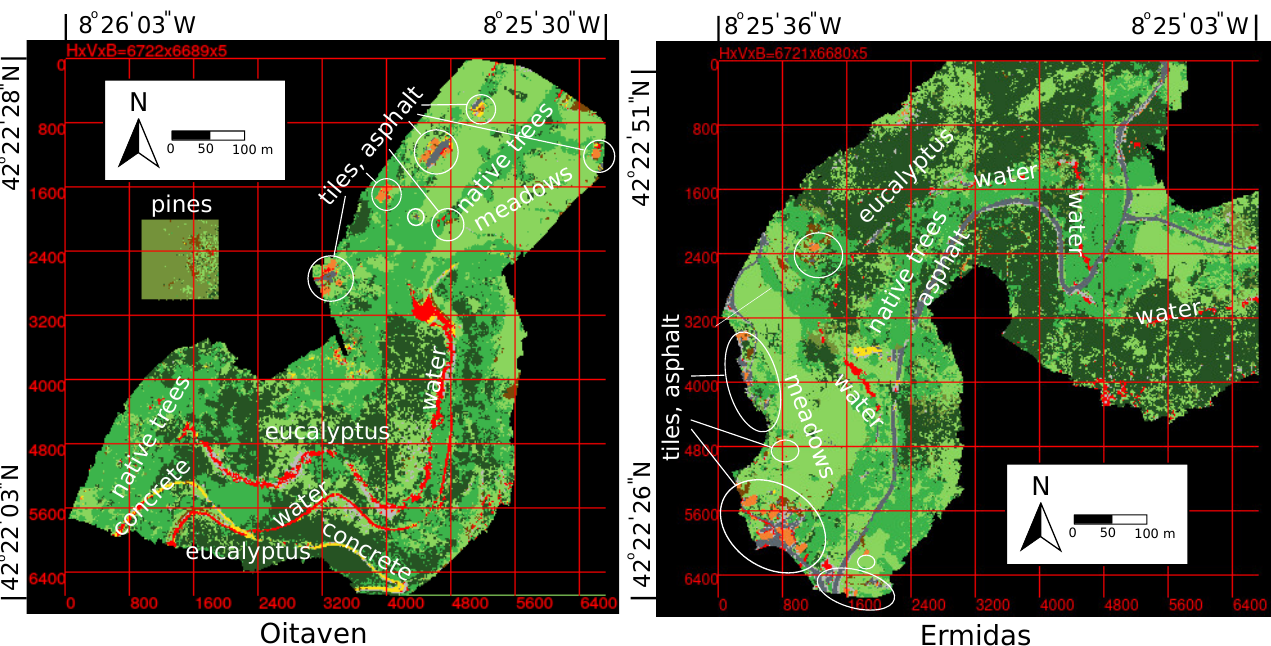
Figure 15. Classification results for the Oitaven and Ermidas datasets, where artificial elements and areas covered by invasive tree species are easily